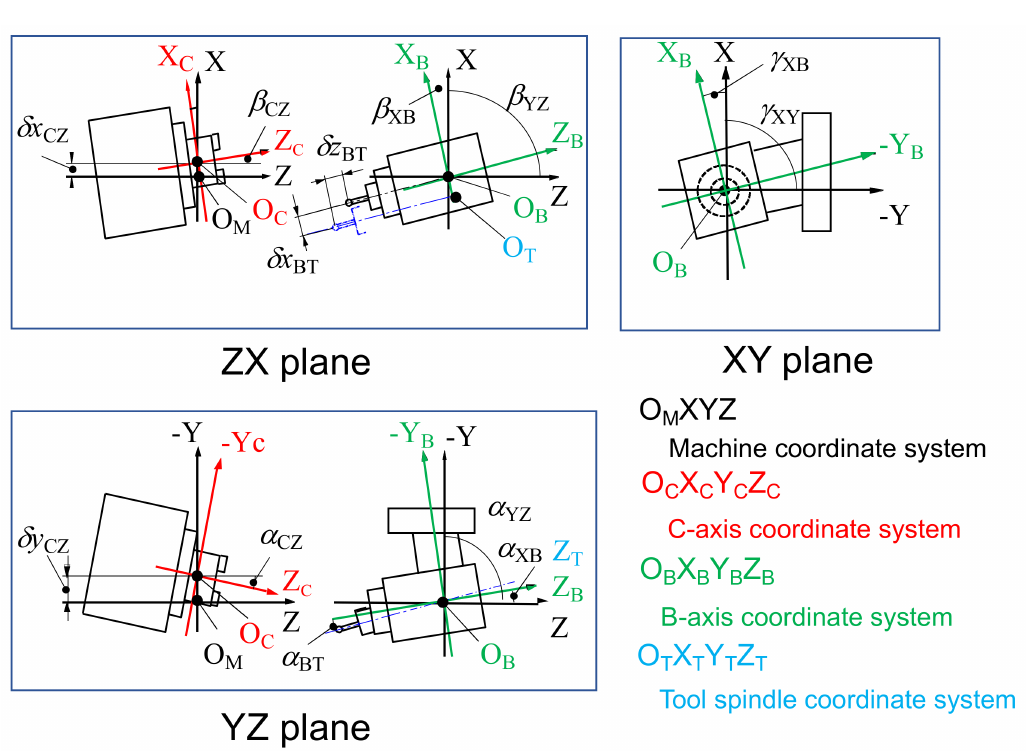
Figure 3. Illustration of coordinate systems and geometric